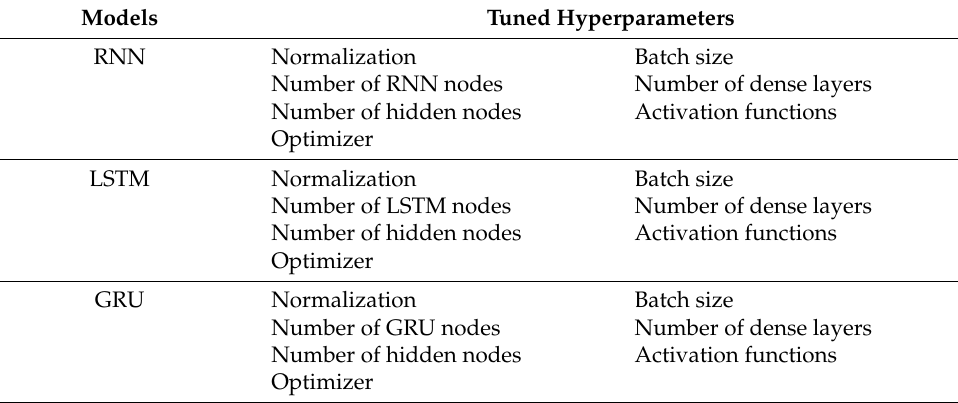
Table 4. Tuned hyperparameter of each model.